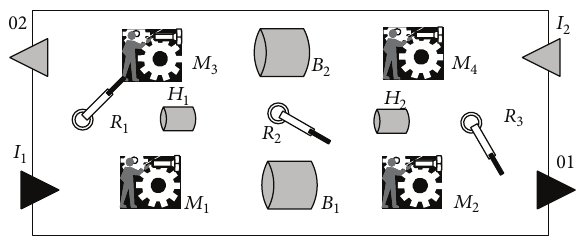
Figure 3: Layout of a manufacturing cell.